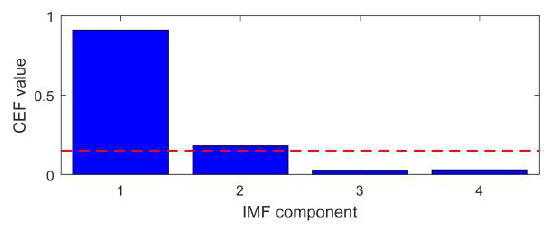
Figure 11. CEF value of each IMF component.